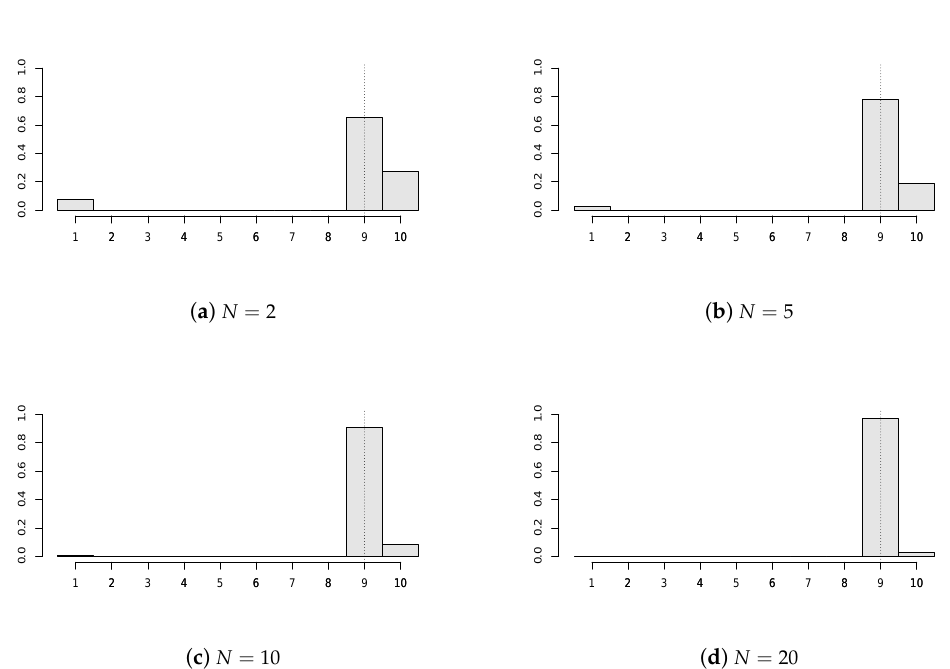
Figure 3. Histograms of the estimated change points (cid:98) τ N for various values of N ( τ = 9, T = 10, σ = 0.2, 50% of the panels are subject to a break of size δ i ∼ U [ 0,2 ] , panel disturbances from AR(1) with t 5